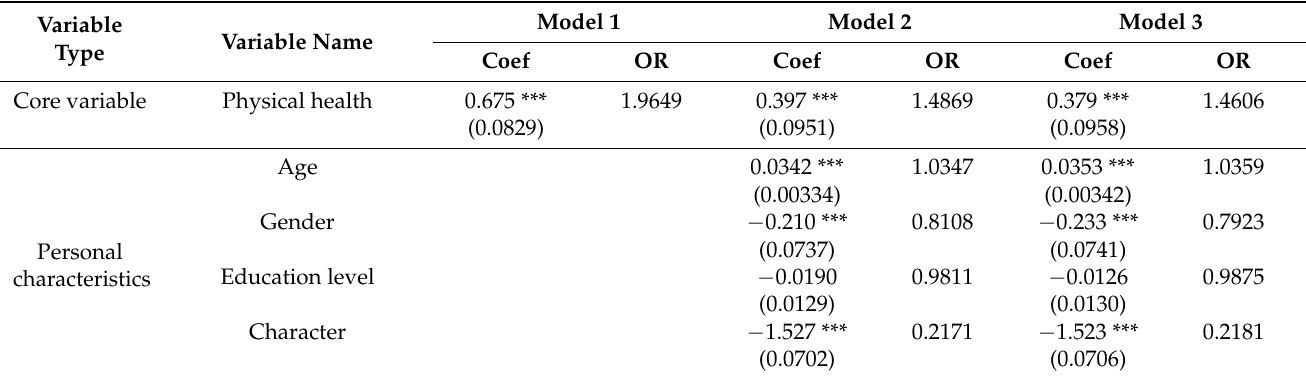
Table 3. Model estimation results of health status on loneliness of rural